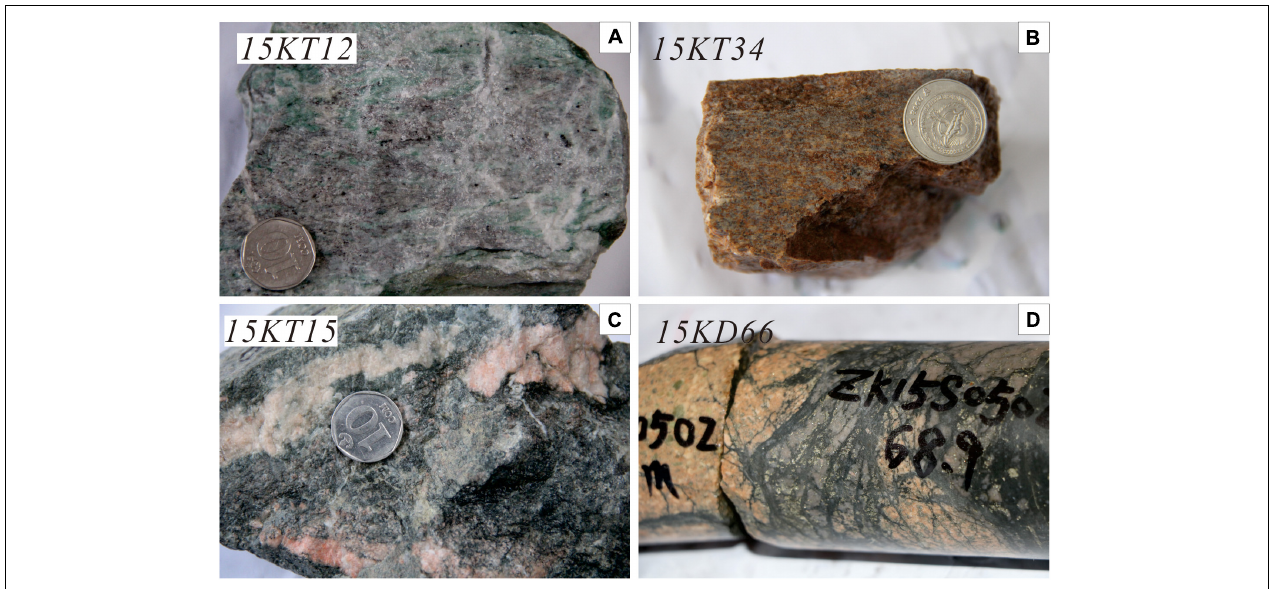
FIGURE 3 | Photographs showing samples used for geochronological study. (A) Fuchsite schist; (B) granitic gneiss; (C) migmatitic amphibolite; and (D) monzogranite